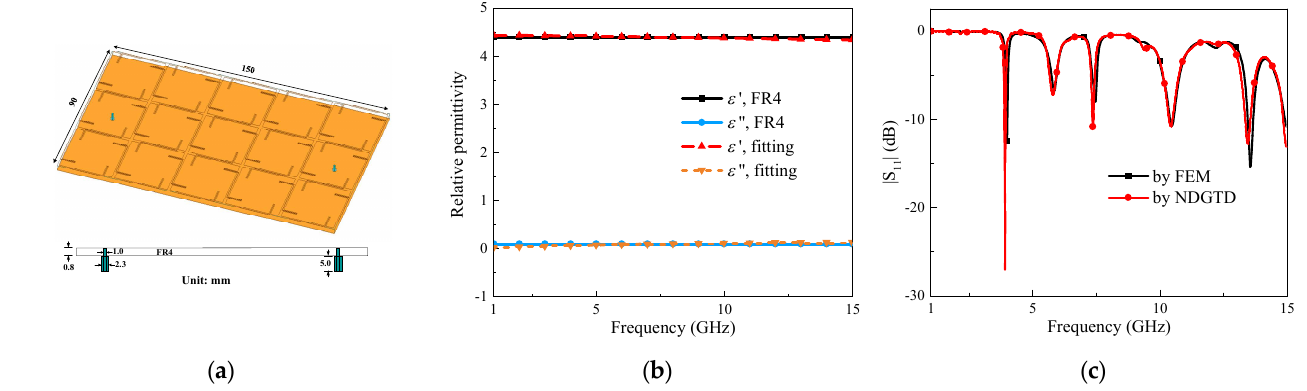
Figure 7. LBS-EBG power plane: ( a ) topology, ( b ) relative permittivity, and ( c ) S-parameters. In the DGTD method, a vector-fitting technique is used to approximate the relative permittivity of the substrate in the band of 1~15 GHz as a partial fraction in terms of real and/or complex-conjugate pole–residue pairs [7], as shown in Figure 7b. The discretization mesh sizes at the port and near the port are 1/75 λ 10GHz and 1/60 λ 10GHz , respectively, and the mesh size of the remaining region is set as 1/30 λ 10GHz . A total of 673254 tetrahedrons are generated, and second-order basis functions are used. The time step ∆ t = 3.5 × − 15 s is chosen. S 11 is solved using the proposed method and the FEM. A good agreement is obtained, as shown in Figure